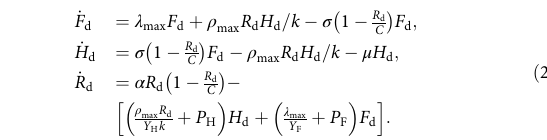
rates of starvation σ ( M ′ ), recovery ρ ( M ′ ), and the maintenance of both starving δ ( M ′ ) and full consumers β ( M ′ ) (see Methods for derivations of competitor rates). Importantly, ε σ , which deter-